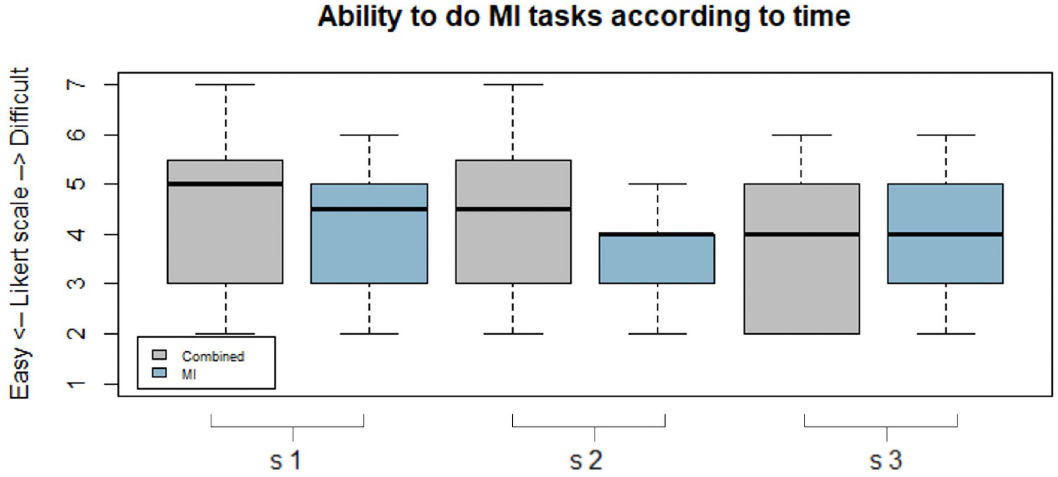
Fig 8. Perceived ability to perform motor imagery tasks according to time. Boxplot representation of the perceived ability to perform motor imagery tasks in combined condition (grey boxplot) and MI condition (blue boxplot) according to time (session 1 (s1) to 3